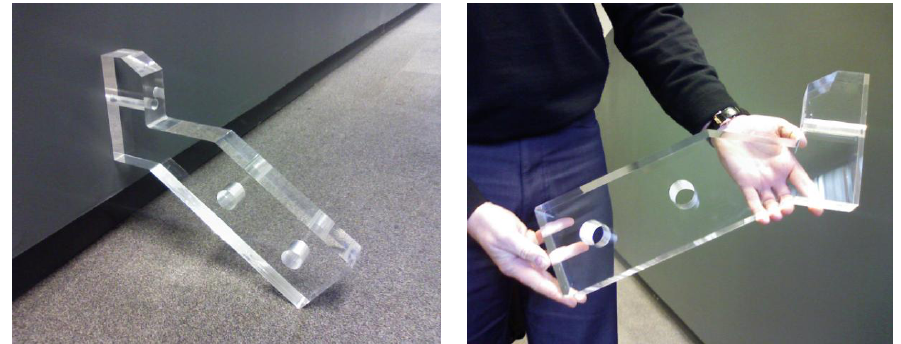
Figure 5: Prototype Acrylic Connection Joint between Rafter and Rafter